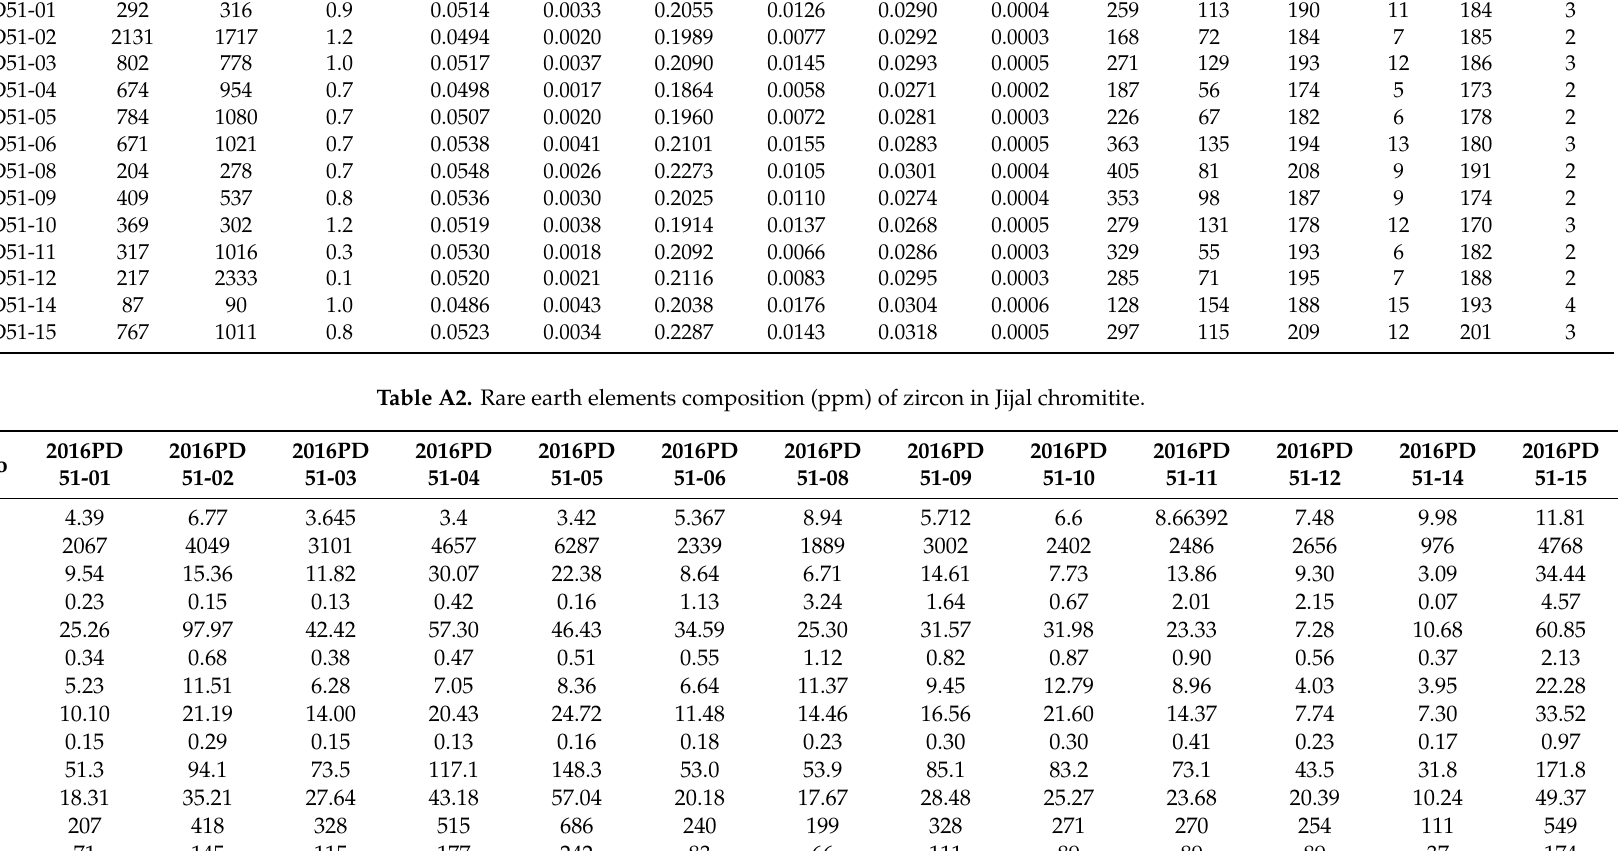
Table A1. Zircon U–Pb data of Jijal chromitite.